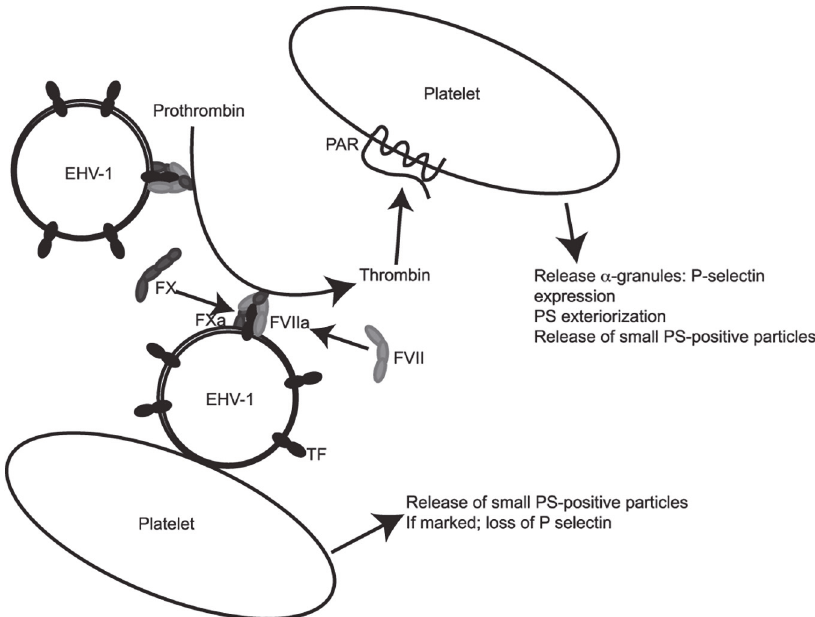
Fig 8. Model for EHV-1-induced activation of platelets. In our model of EHV-1-induced platelet activation, we propose that the virus first binds to platelets, which triggers platelet fragmentation or microvesiculation in a TF- and thrombin-independent manner. Concurrently, factor VII (FVII) forms a complex with TF in the viral envelope and activates factor X (FX), with FXa generating thrombin in the vicinity of or on the surface of platelets. Thrombin generation may be propagated by phosphatidylserine (PS) in the viral envelope. Thrombin binds to protease-activated receptors (PAR) on platelet surfaces, inducing release of α -granules with subsequent surface P-selectin and PS expression and additional microvesiculation. If marked, microvesiculation results in loss of membrane-anchored P-selectin on microparticles. Depending on the viral strain or load, thrombin may be generated on the surface of virus not attached to